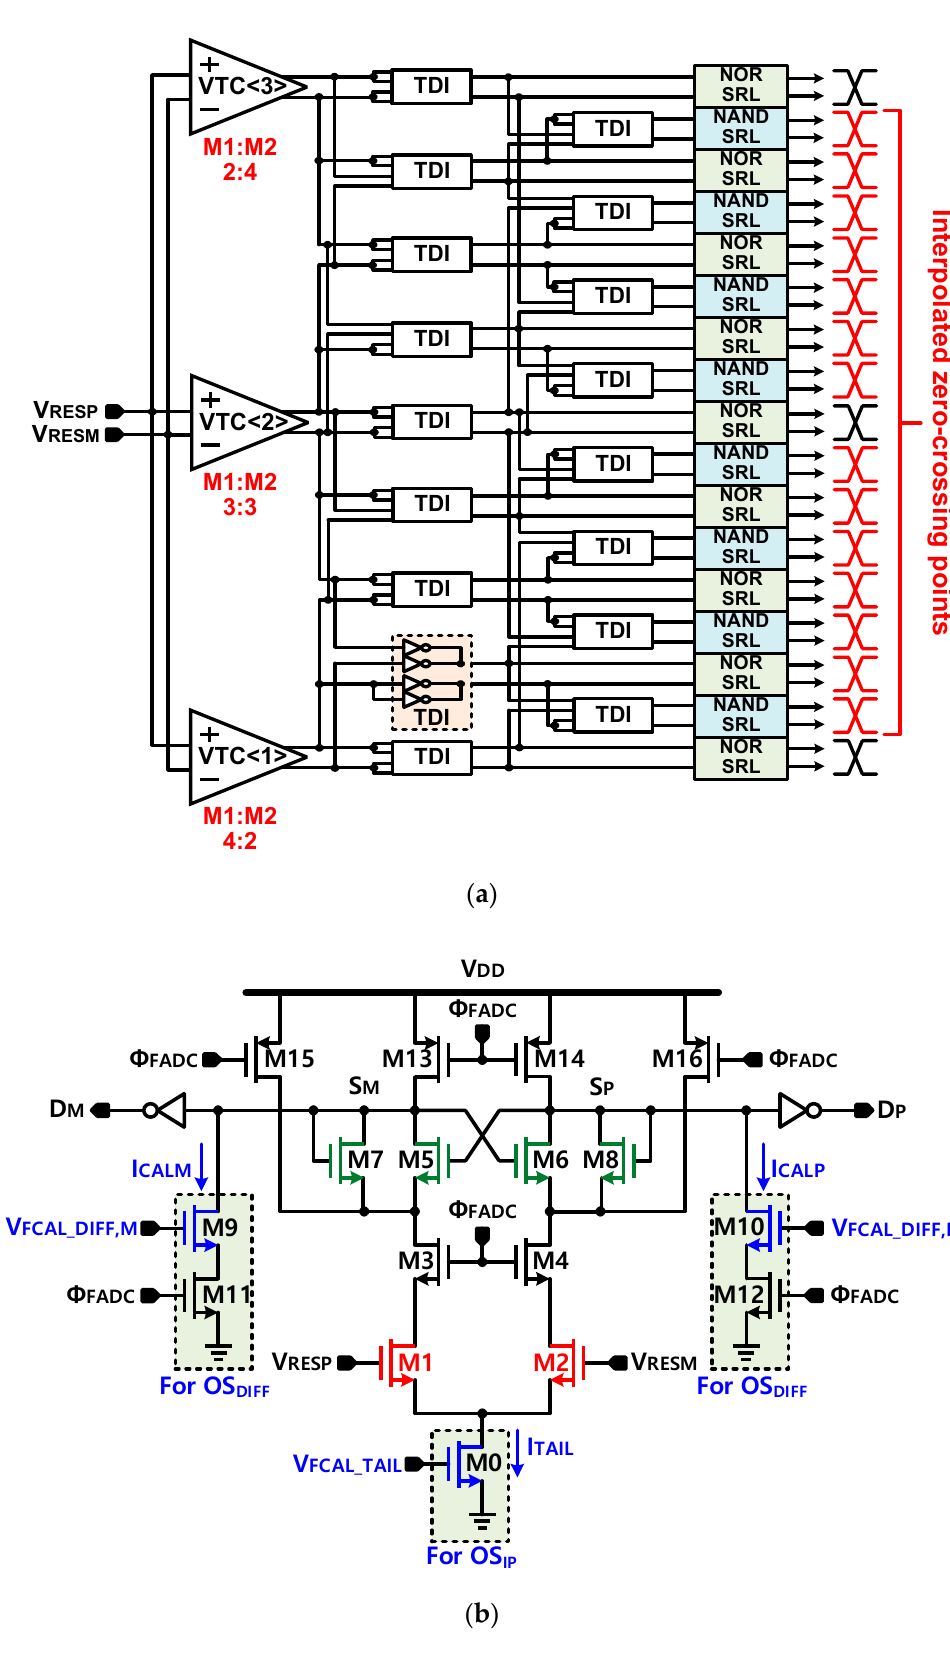
Figure 6. ( a ) Four-bit 8-time time-domain interpolating FADC. ( b ) Reference-embedded VTC with positive feedback for gain boosting.